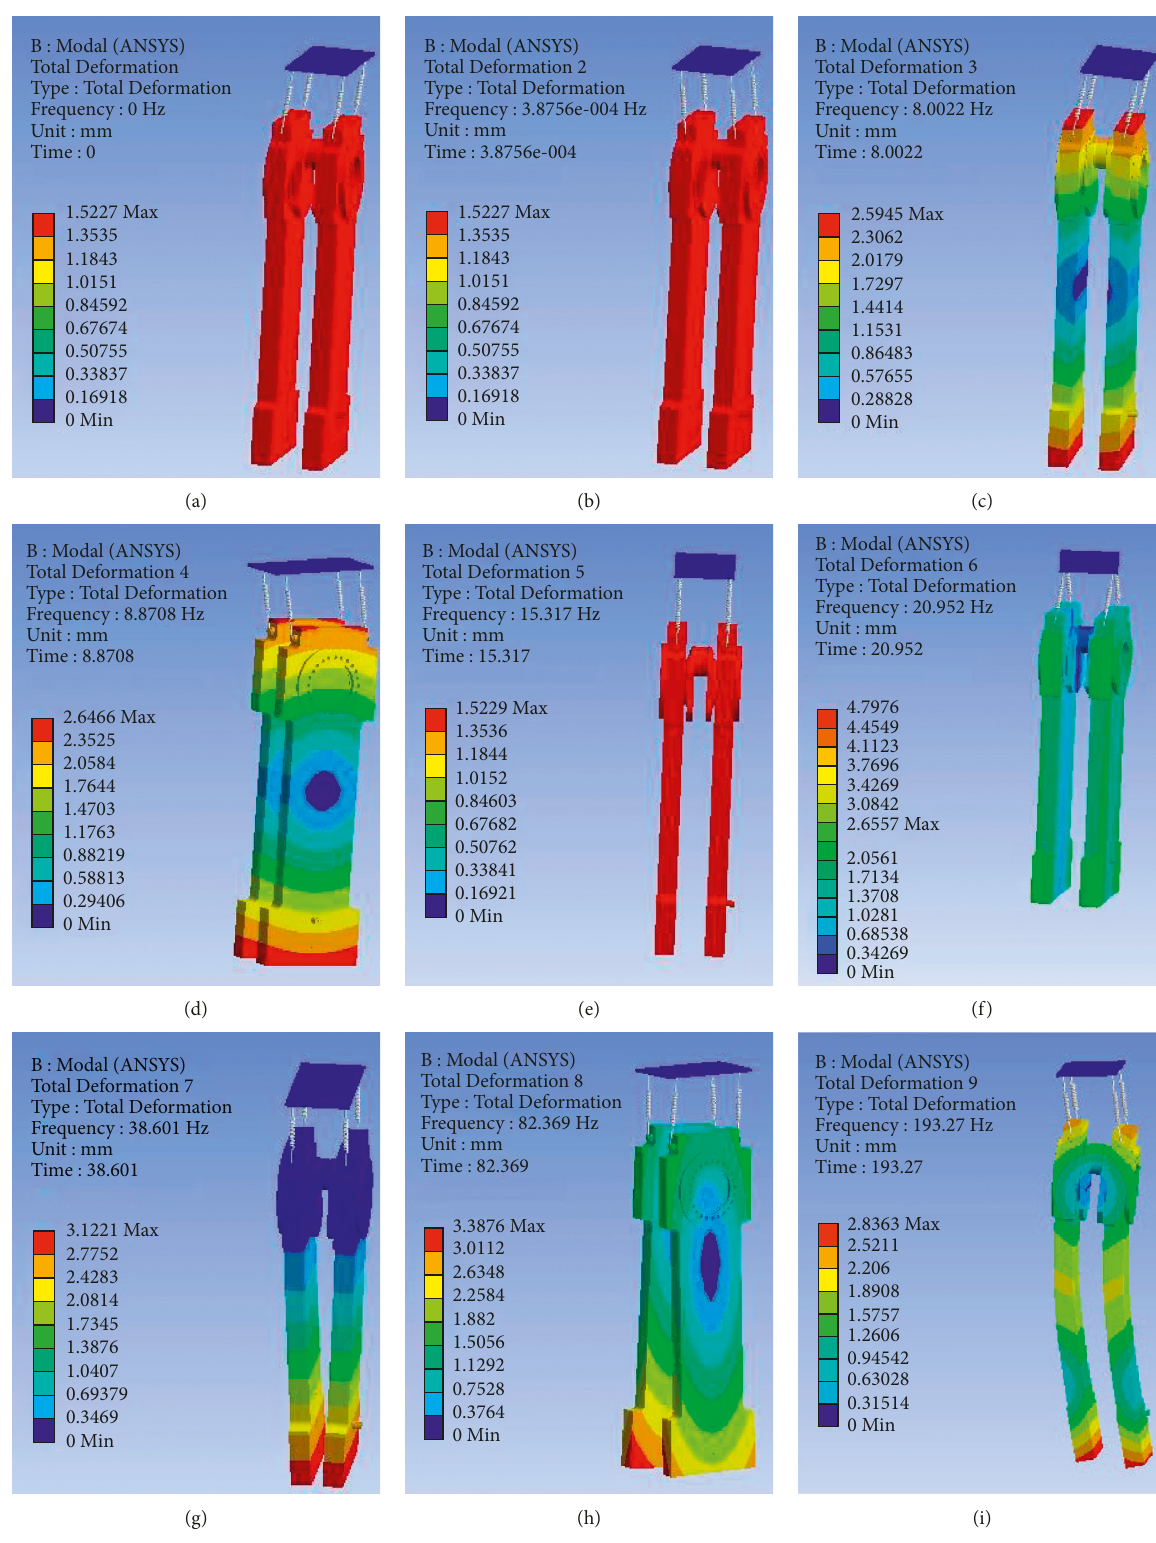
Figure 6: Natural frequency and mode shape results from the three-dimensional finite element model. (a) Mode 1st, (b) Mode 2nd, (c) mode 3rd, (d) mode 4th, (e) mode 5th, (f) mode 6th, (g) mode 7th, (h) mode 8th, and (i) mode